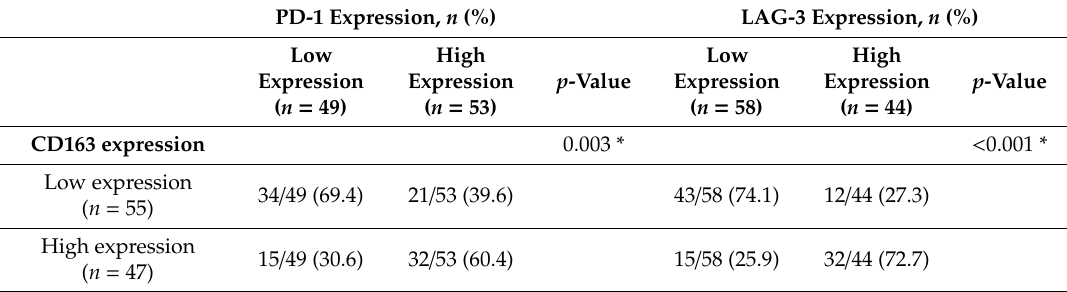
Table 2. Correlations between CD163 and PD-1 or LAG-3